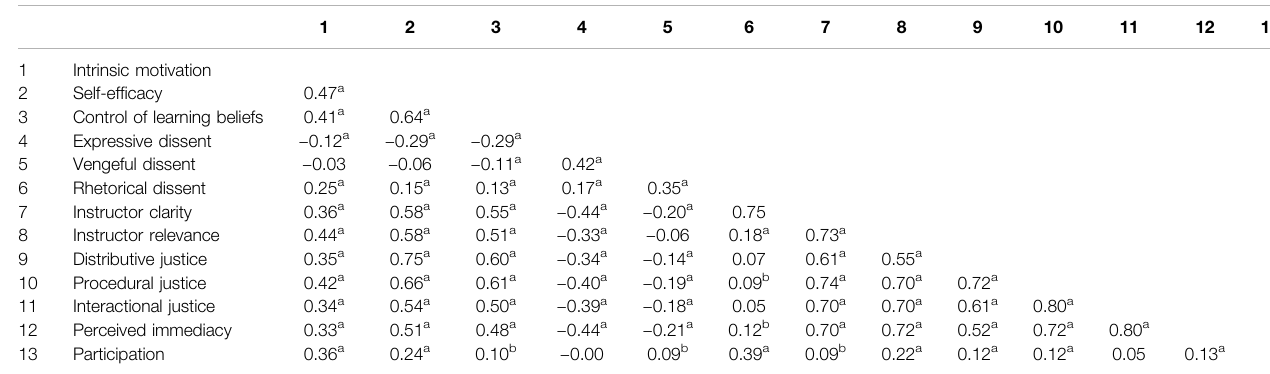
TABLE 4 | Correlation